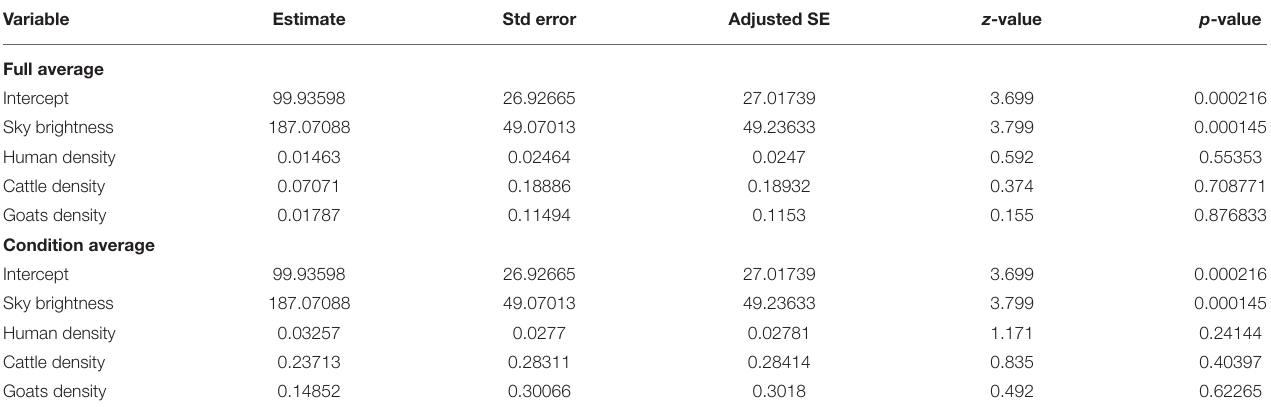
TABLE 3 | Model-averaged coefficients for the five models selected with similar support from AICc.